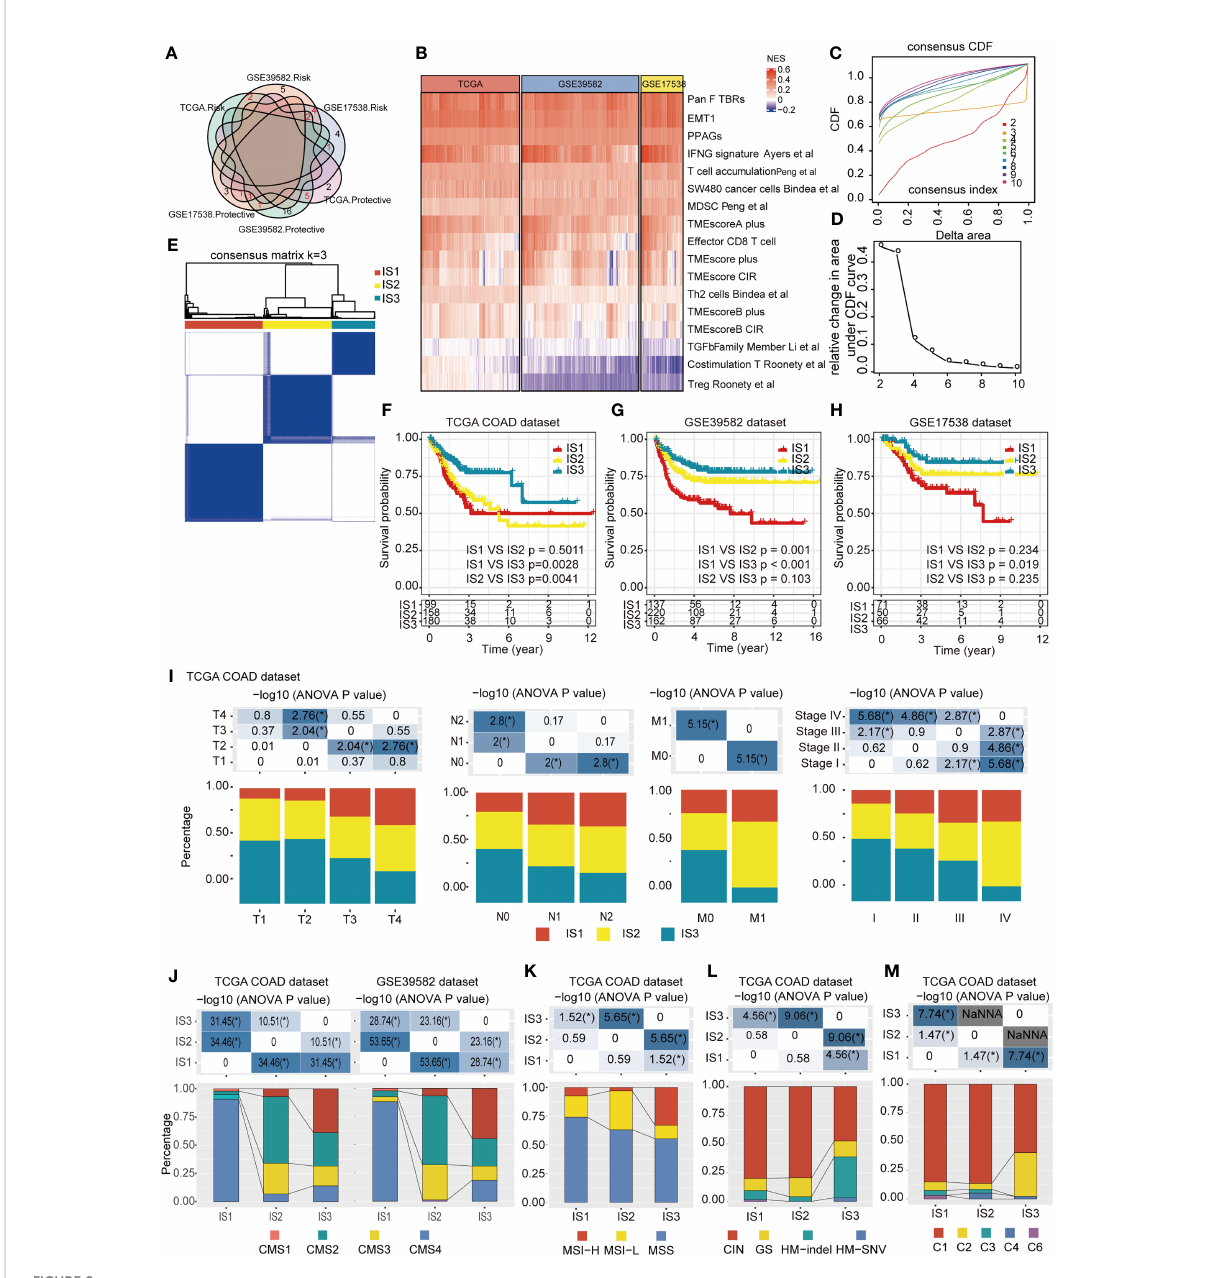
FIGURE 2 Identi fi cation of potential immune subtypes of COAD. (A) . Overlapping prognostic immune characteristics among TCGA -COAD, GSE39582, and GSE17538 cohorts; the lines correspond to different gene sets in each dataset; red numbers represent the intersection genes of different datasets.